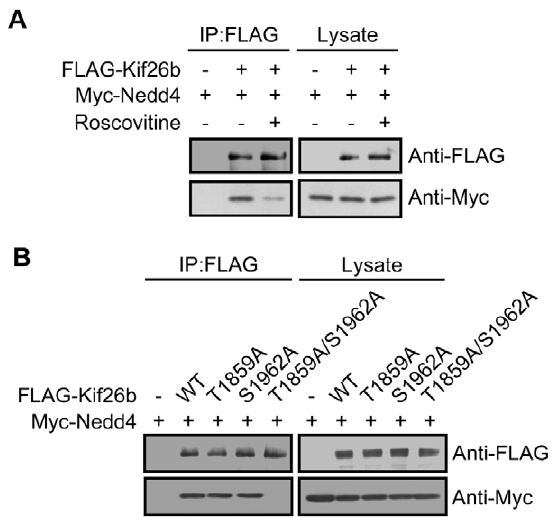
Figure 3. Kif26b interacts with Nedd4 in a phosphorylation- dependent manner. A . HEK293 cells were transfected with the indicated constructs. At 48 h after post-transfection, cells were treated for 6 h with DMSO (-) or Roscovitine ( + ; 20 m M) and then lysed, and the FLAG-tagged proteins were immunoprecipitated with anti-FLAG beads. The precipitates were analyzed by immunoblotting with the indicated antibodies. B. HEK293 cells were transfected with the indicated constructs. The FLAG-tagged proteins were immunoprecipitated from the cell lysates with anti-FLAG beads. The precipitates were analyzed by immunoblotting with the indicated antibodies. involved Lys48 but not Lys63 of ubiquitin (Figure S3B). Lys48-